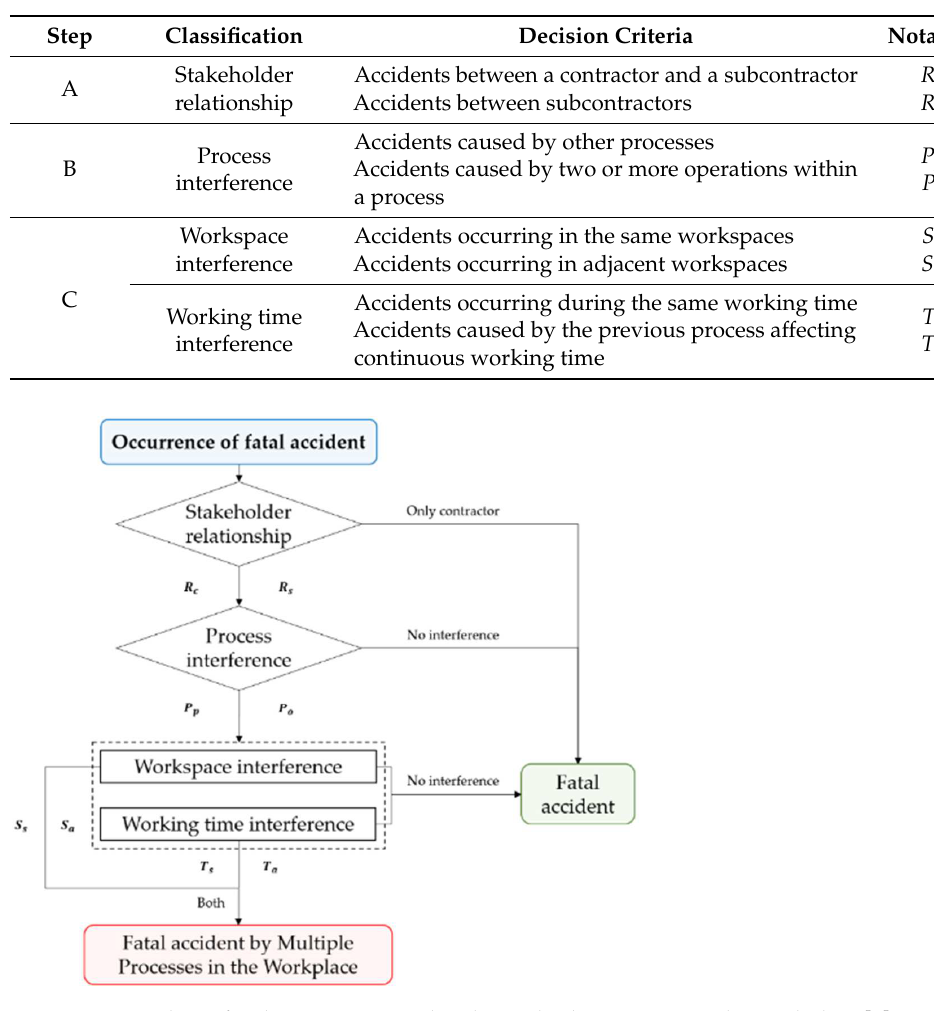
Figure 2. Procedures for determining accident by multiple processes in the workplace